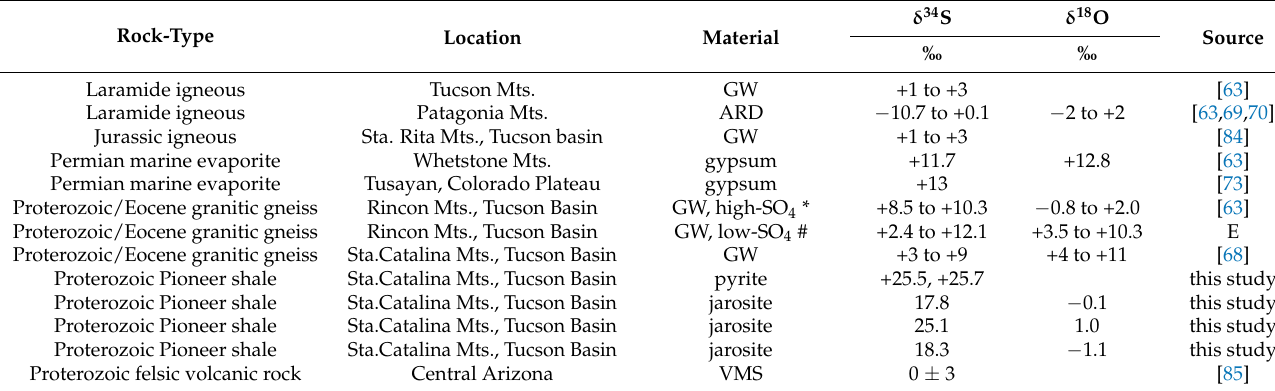
Table 1. Isotope composition of bedrock sulfur in the study